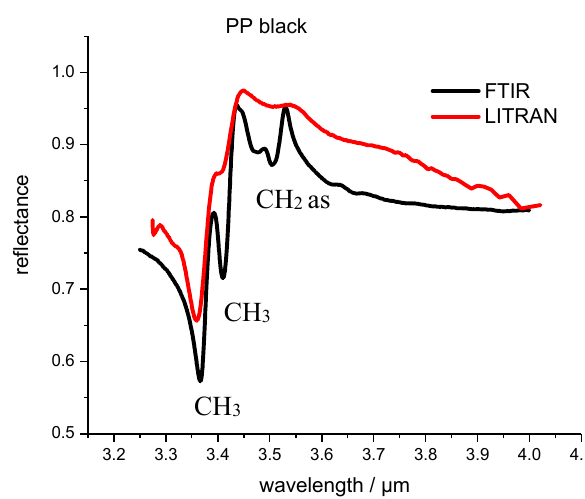
Figure 3. Fourier-transform infrared spectrometers (FTIR) and the measurements with the photon up-conversion system are referred to as LITRAN (from Light Transformation) of the reflectance spectrum of PP black polymer. LITRAN is the spectrum measured with the up conversion system.